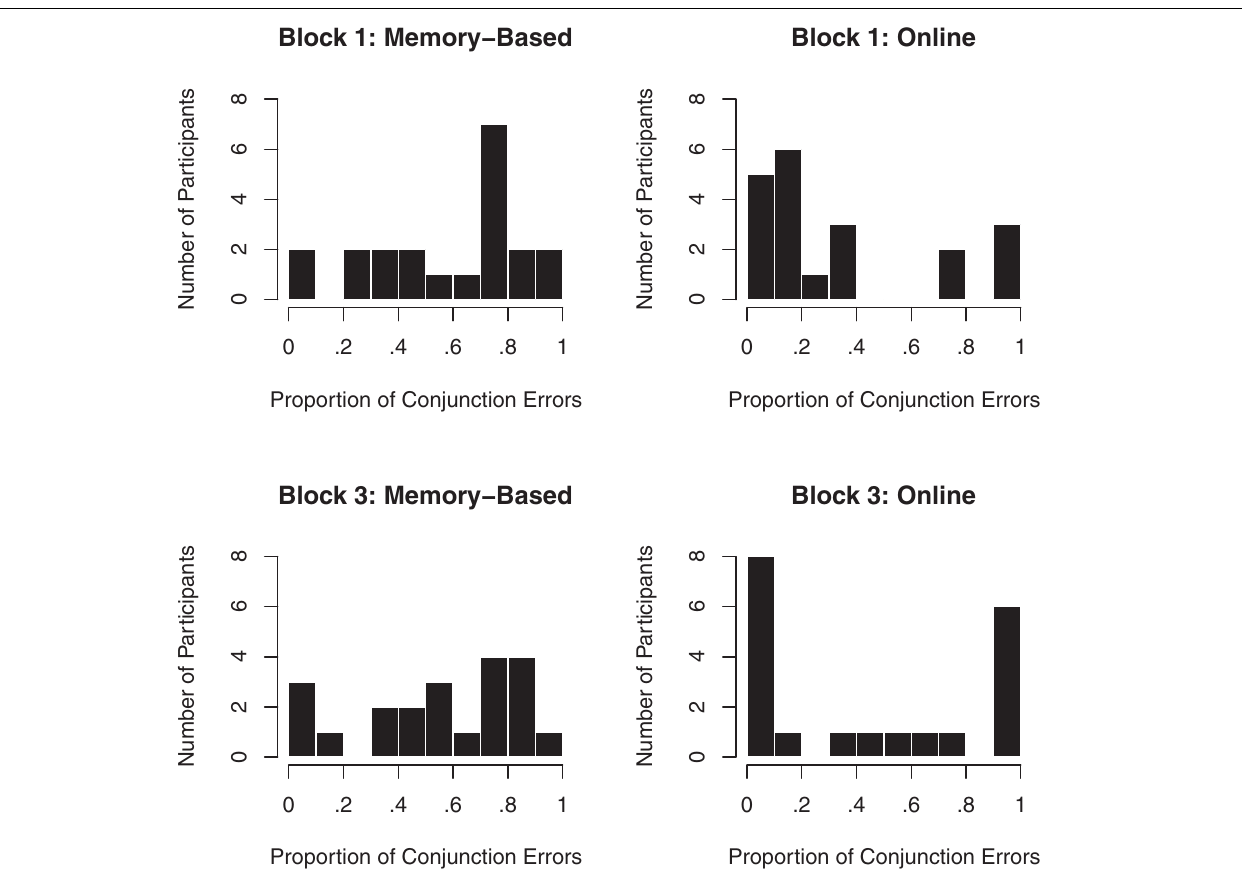
FIGURE 2 | Distributions of conjunction error rates in Experiment 2.